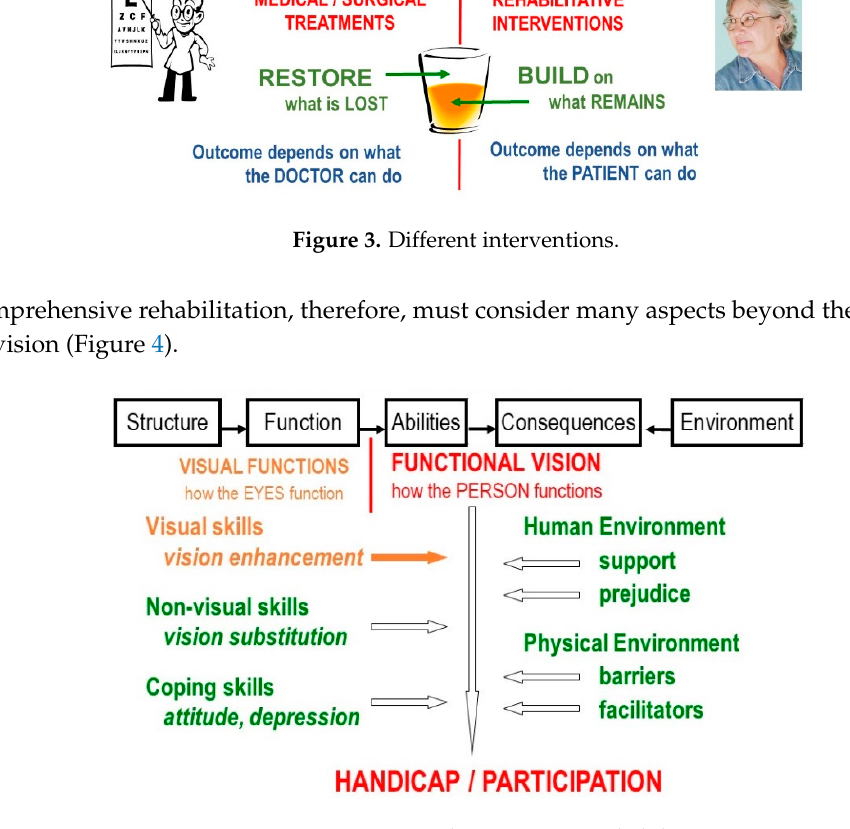
Figure 4. Factors in comprehensive vision rehabilitation.